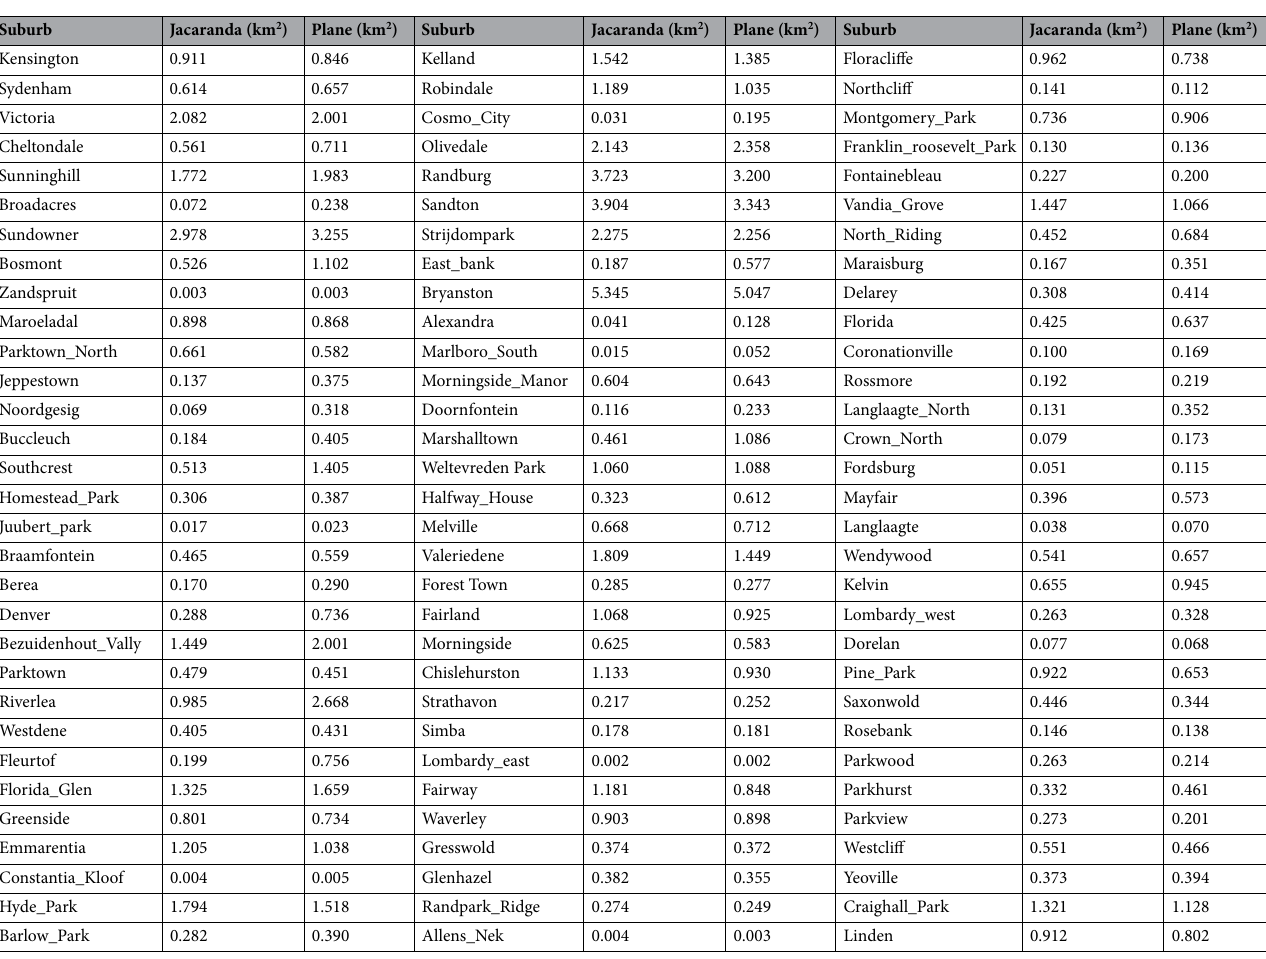
Table 4. Plane and jacaranda canopy tree coverage for each of the suburbs in the city of